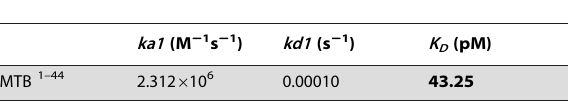
Table 2. Kinetics of PAI-1 interactions with SMTB 1–44